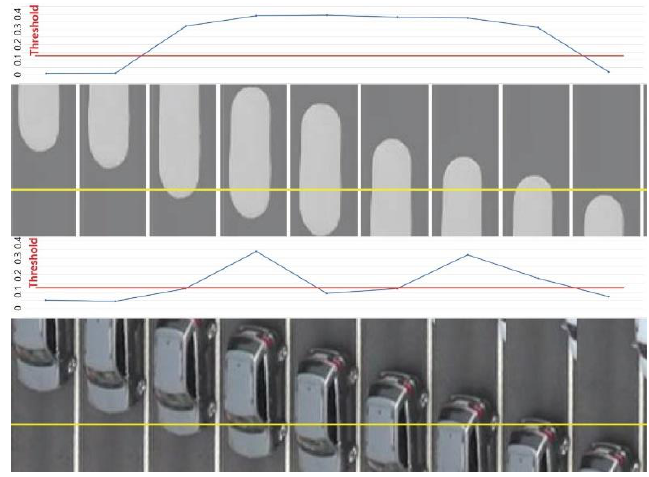
Figure 8. Signal profile comparison between a real vehicle (bottom) and a synthesized vehicle shape (top).